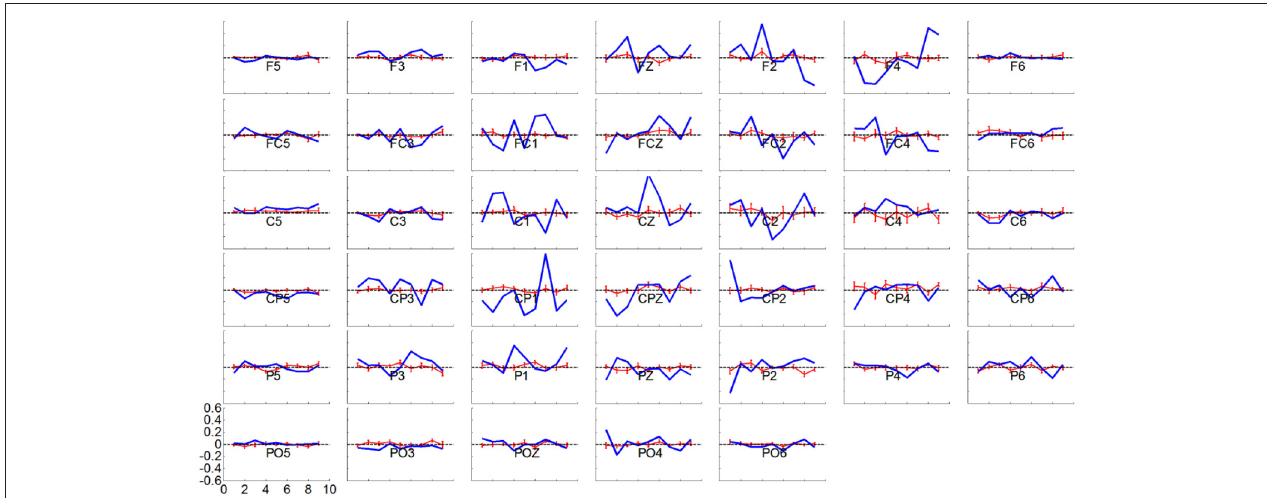
FIGURE 9 | Variation in weighting coefficient for each electrode by the CSP method for a particular subject in blue line and averaged over subjects ± S.E.M in red line, across runs, in a session of online BCI control. The spatial filter for each subject was normalized and then averaged over all of the subjects in a session. A horizontal dash line at y = 0 is shown in each